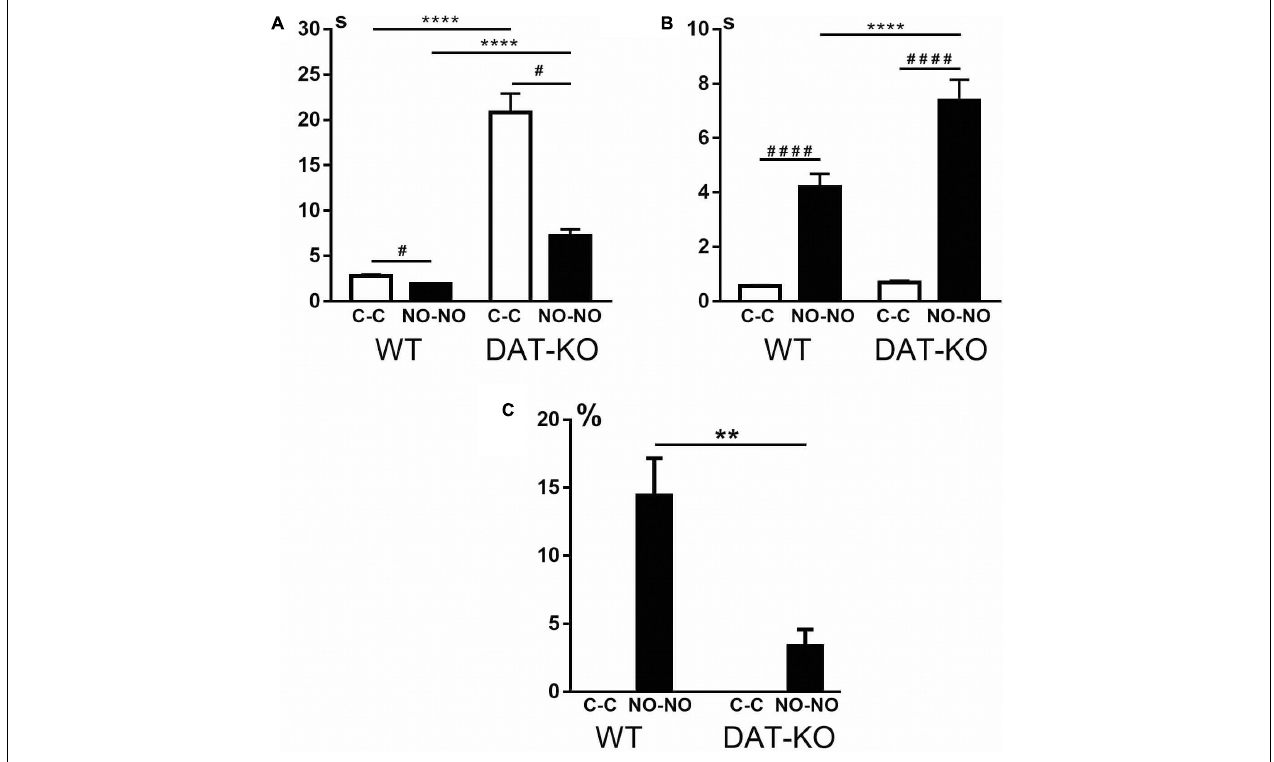
FIGURE 4 | Comparison of latent periods of running to the first object (A) , time of object exploration (B) , and the number of erroneous trials (C) in WT and DAT-KO rats during presentation of cubes (C-C, white columns) and novel objects (NO-NO, black columns); # p < 0.05; ** p < 0.01; **** or #### p < 0.0001; one-way Kruskal–Wallis test combined with Dunn’s multiple-comparison post hoc test. WT, wild-type; DAT-KO, dopamine transporter knockout.